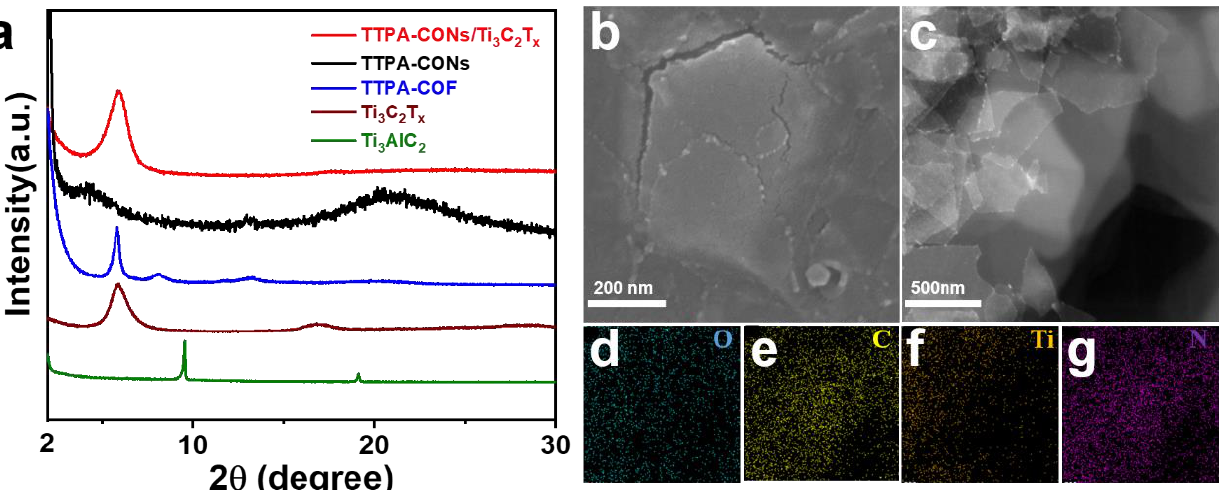
Figure 1. ( a ) PXRD diffraction patterns of TTPA-CONs/Ti 3 C 2 T x , TTPA-CONs, TTPA-COF, Ti 3 C 2 T x , and Ti 3 AlC 2 . ( b ) SEM, ( c ) TEM, and ( d − g ) elemental mapping of TTPA-CONs/Ti 3 C 2 T x composites. SEM images of the TTPA-CONs/Ti 3 C 2 T x composites reveal the sheet-like morphology (Figure 1a and Figure S3a,b). The low contrast of TEM images corresponds to the ultrathin nature of the TTPA-CONs/Ti 3 C 2 T x composites (Figure 1c and Figure S4a,b). As shown in Figure 1d–g, O, Ti, C, and N are uniformly distributed throughout the nanostructure, showing the homogeneity of TTPA-CONs and Ti 3 C 2 T x . To investigate the composite mode between TTPA-CONs and Ti 3 C 2 T x , we measured the zeta potential of TTPA-COF, TTPA- CONs, and Ti 3 C 2 T x . As shown in Figure S5, Ti 3 C 2 T x exhibits a potential of − 29.33 mV, which can be attributed to the presence of a large number of surface end groups (e.g., -O). Al- though TTPA-COF also exhibits a negative potential of -18.52 mV, the TTPA-CONs exhibit a positive potential of 65.13 mV after the functionalization of their exfoliated nanosheets with PEI. This suggests that TTPA-CONs and Ti 3 C 2 T x can be bound by electrostatic adsorption. X-ray photoelectron spectroscopy (XPS) measurements were used to further inves- tigate the surface characteristics of the composites. The XPS survey spectra of TTPA- CONs/Ti 3 C 2 T x in Figure S6 show the presence of N, O, Ti, and C elements. As shown in Figure 2a, the high-resolution C1s spectra of TTPA-CONs/Ti 3 C 2 T x exhibit a series of typical peaks at 281.7 eV, 284.5 eV, 285.8 eV, 286.9 eV, and 288.14 eV, which can be assigned to C-Ti bonds, amorphous carbon, C-O bonds, C=N bonds, and C-N bonds, respectively, indicating the successful formation of TTPA-CONs. Figure 2b shows the high-resolution Ti 2p spectrum, providing five characteristic peaks located at 455.08 eV, 456.5 eV, 459.7 eV, 461.2 eV, and 462.5 eV, which can be ascribed to the corresponding bonds of Ti-C, Ti (iii), Ti-O, and Ti (ii) and Ti (iii), respectively. Among them, the presence of Ti-O indicates the implantation of functional groups (-O) on the surface of Ti 3 C 2 T x . In addition to peaks at 399.7 eV (C-N bond) and 398.1 eV (C=N bond), the N 1s spectrum obtained from CONs shows a peak at 403.2 eV, which can be attributed to the N-O bond (Figure 2c). The presence of this bond suggests that TTPA-CONs and Ti 3 C 2 T x are bound by implanting functional groups O implanted on the surface of Ti 3 C 2 T x . The typical peak at 531.6 eV on the O 1s spectrum (N-O bond) also indicates a strong interfacial interaction between TTPA-CONs and Ti 3 C 2 T x (Figure